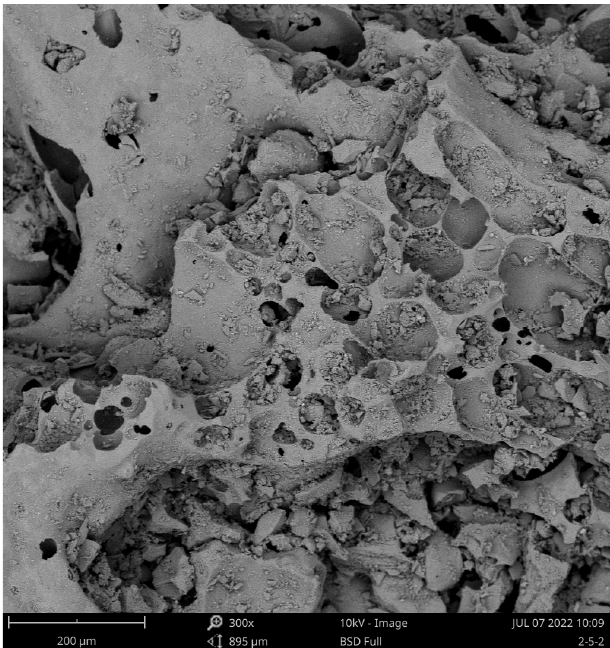
Figure 2. SEM of volcanic soil particle.